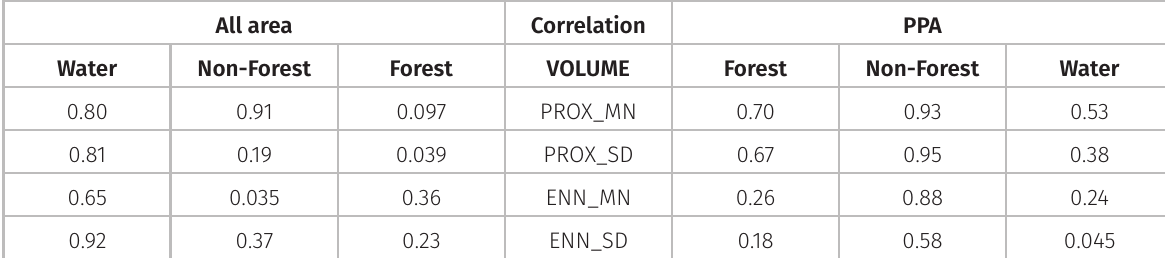
Table V. Correlation between Serra Azul reservoir volume and connectivity landscape metrics throughout the study region and in the permanent preservation